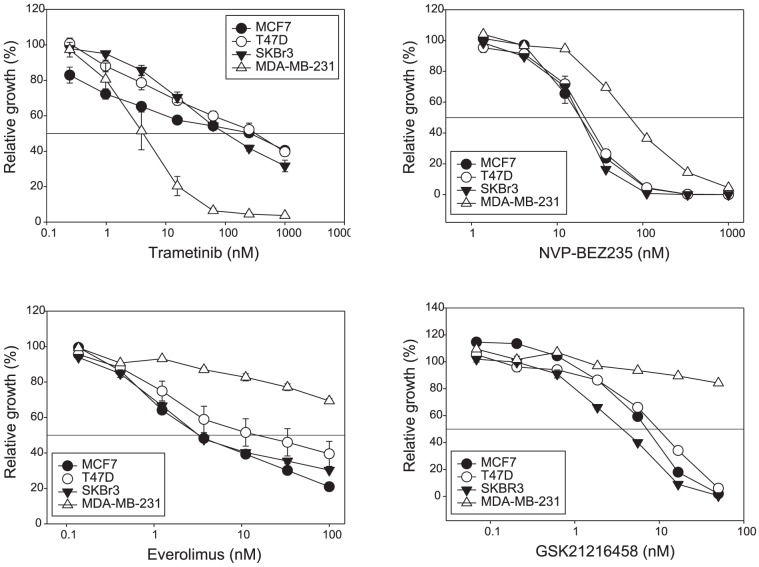
Growth inhibitory effects of drug treatments in MCF-7, T47D, SKBr3 and MDA-MB-231 cell line.Cells were treated with trametinib, everolimus, NVP-BEZ235 or GSK2126458 for 3 days and [3H]-thymidine added for the last 6 hours. Results are shown as the mean ± standard error from duplicate experiments.